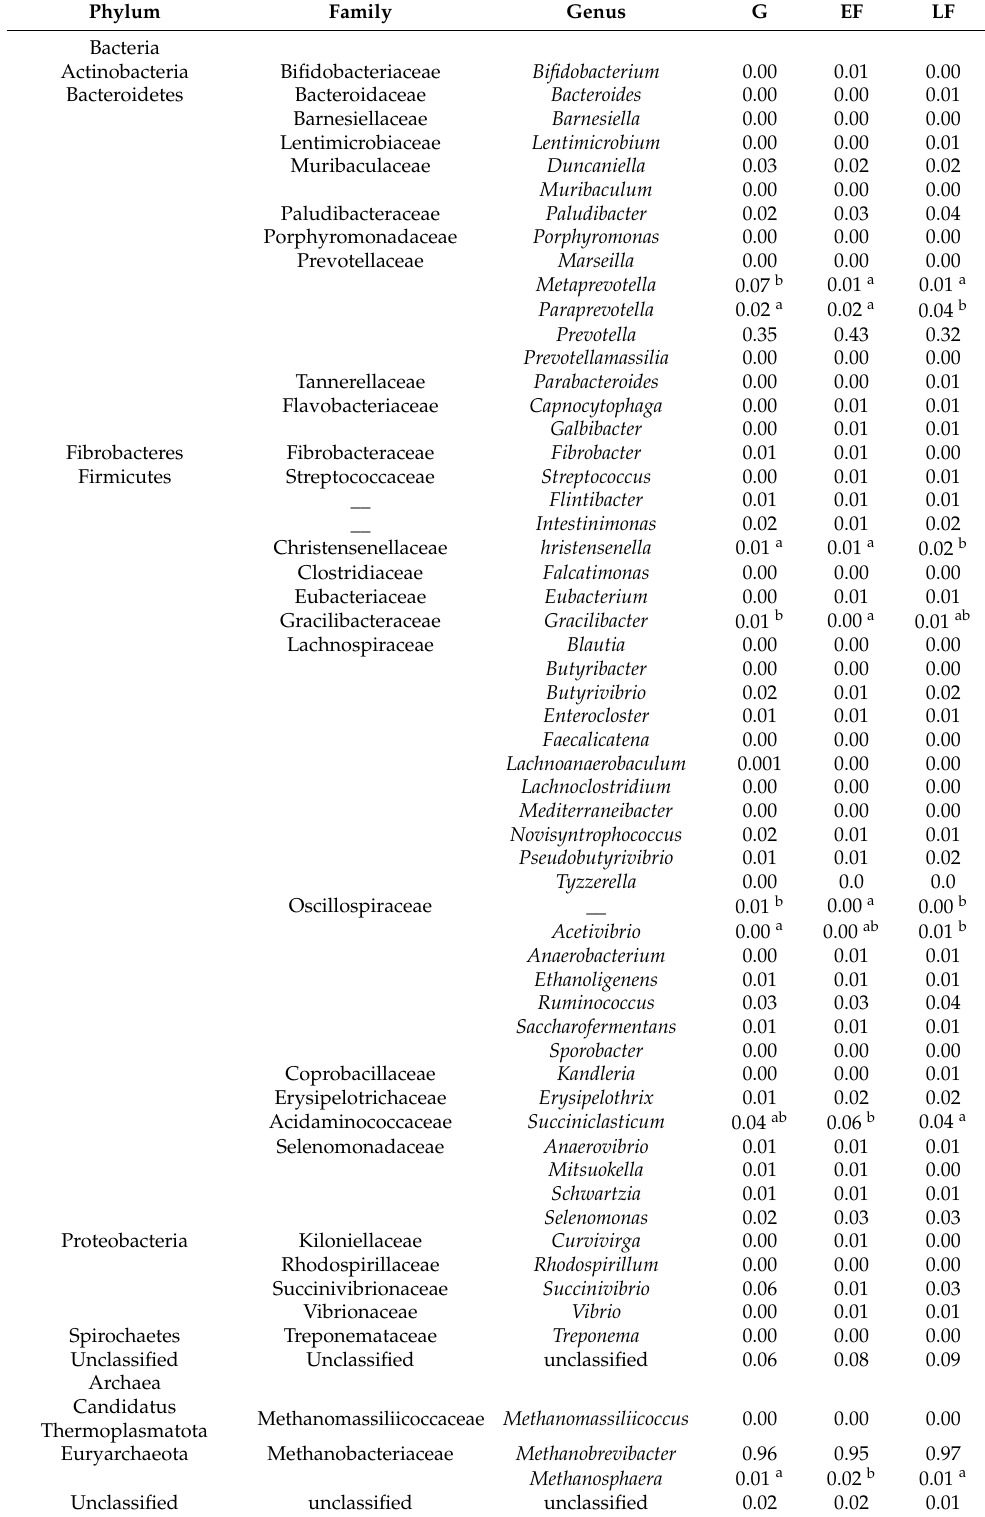
Table 5. Relative abundance of dominant taxa in Hanwoo steers according to different growth stages representing >0.1% of total